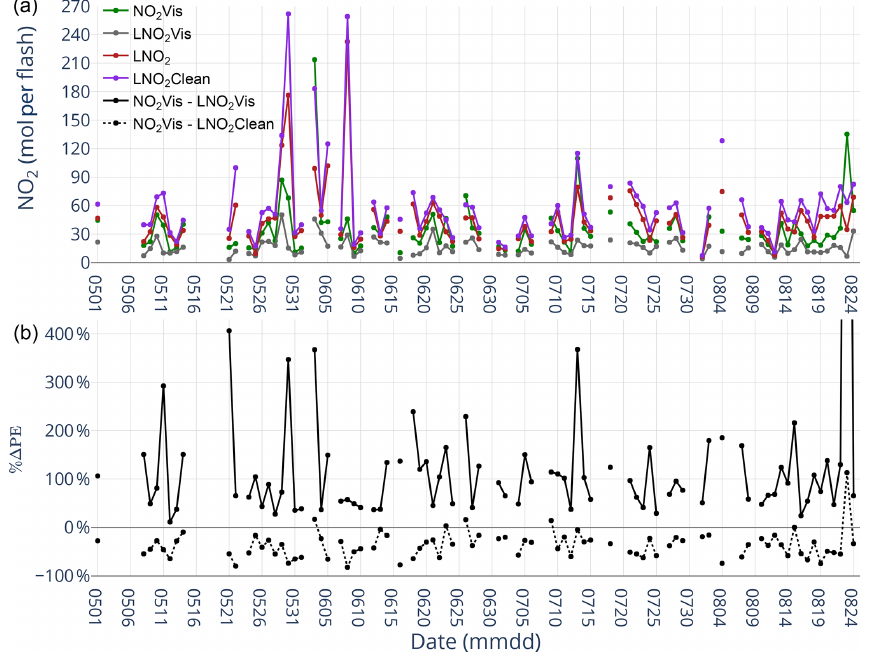
Figure 3. (a) Time series of NO 2 Vis, LNO 2 Vis, LNO 2 , and LNO 2 Clean production per day over the CONUS for MJJA 2014 with CRF ≥ 90% and a flash threshold of 2400 flashes per 2.4h. (b) Time series of the percent differences between NO 2 Vis and LNO 2 Vis and the percent differences between NO 2 Vis and LNO 2 Clean with CRF ≥ 90%. The value of the black dot on 23 August (not shown) is 1958%.